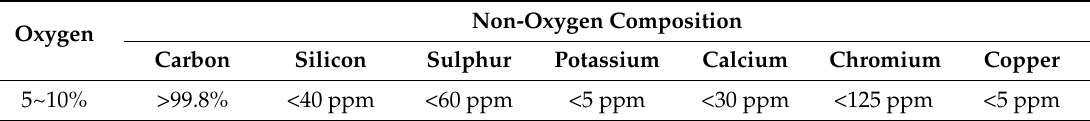
Table 2. Chemical Composition of GONFs (edge-oxidized) [16].